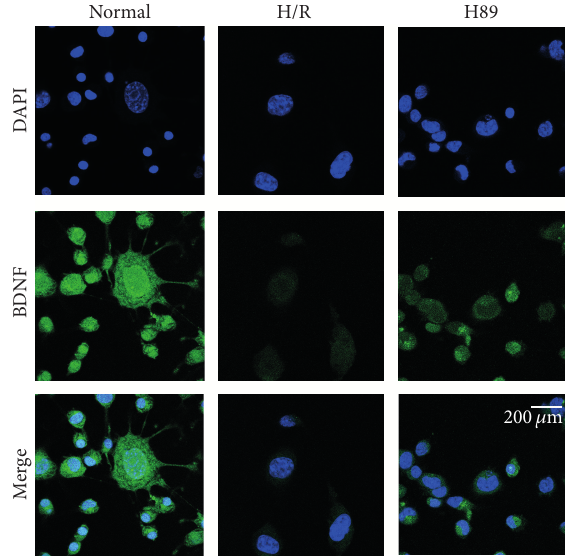
Figure 6: The measurement of BDNF expression in Neuro2A cells after H/R-induced injury. The level of BDNF was evaluated by immunocytochemistry. This image shows that the expression of BDNFintheH/Rgroupwasreducedcomparedtothenormalgroup. H89 pretreatment increased the expression of BDNF in N2A cells in spite of hypoxia reperfusion injury. Scale bar: 200 𝜇 m, BDNF: green, 4 󸀠 ,6-diamidino-2-phenylindole (DAPI): blue, normal: the normal control group, H/R: 4 hr hypoxia and 18hr reperfusion injury group, and H89: 2 hr PKA inhibitor H89 treatment group before 4hr hypoxia and 18hr reperfusion